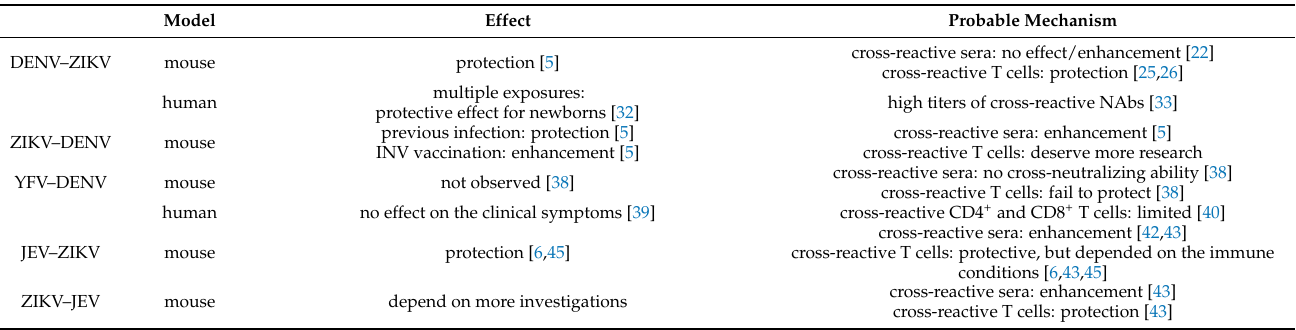
Table 2. The in vivo effect and probable mechanism of cross-reactive immunity on sequential infection among five mosquito-borne